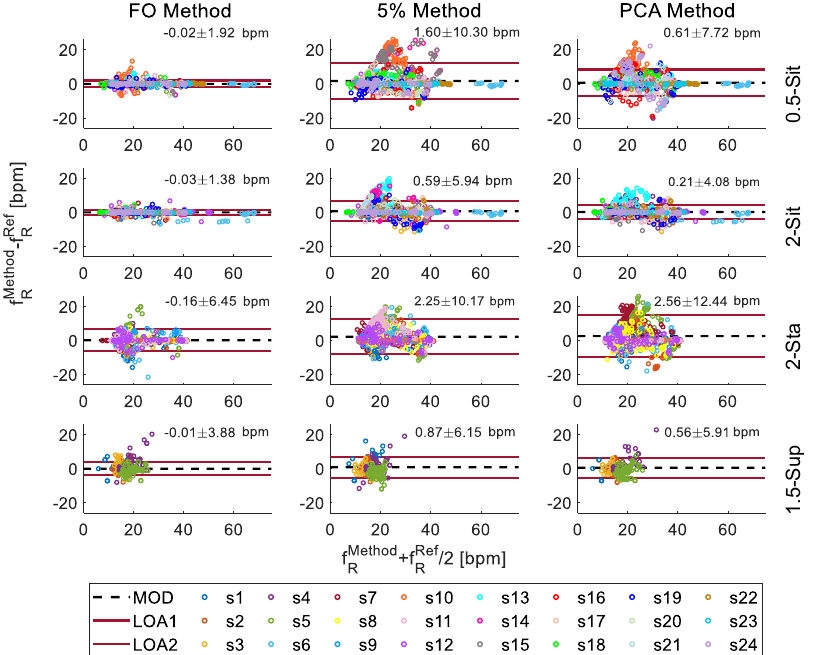
Figure 7. Distributions of the error ( f Method FO, in red PCA and in green 5%). On the y-axis the percentage occurrence frequency. In the box, the percentage of the measurements with errors below ± 1 bpm.